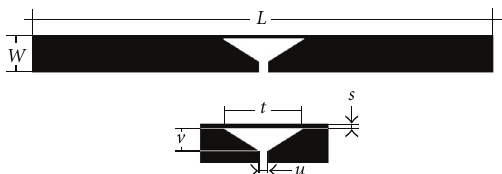
Figure 1: Shape and dimensions of the printed tag